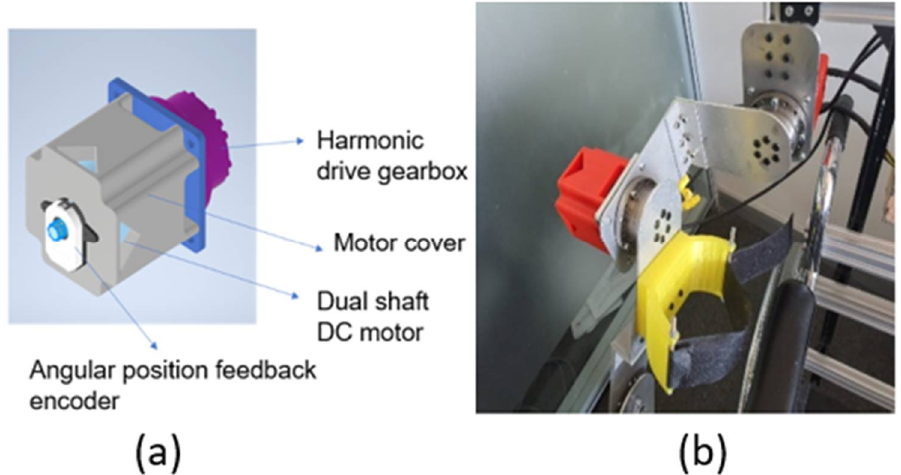
Figure 15. Actuator module unit for SAMA shoulder rotations. The CAD design is shown on the left ( a ), while the whole actuator module assembly is shown on the right ( b